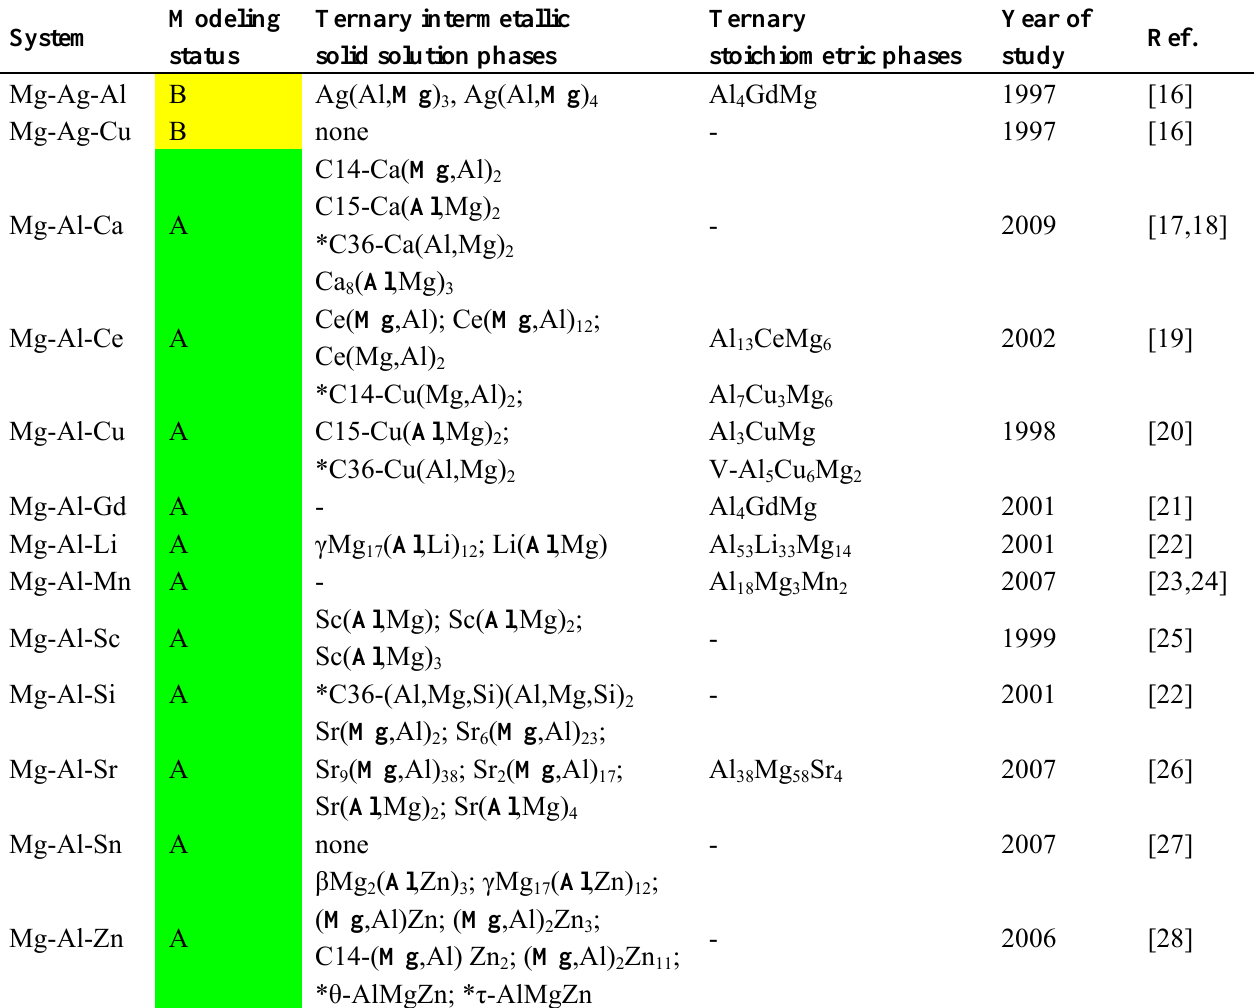
Table 2. Ternary Mg systems with complete thermodynamic descriptions and their classified modeling status. In ternary intermetallic solid solution phases extending from a binary phase with limited solubility of the third component, the majority component is marked in bold